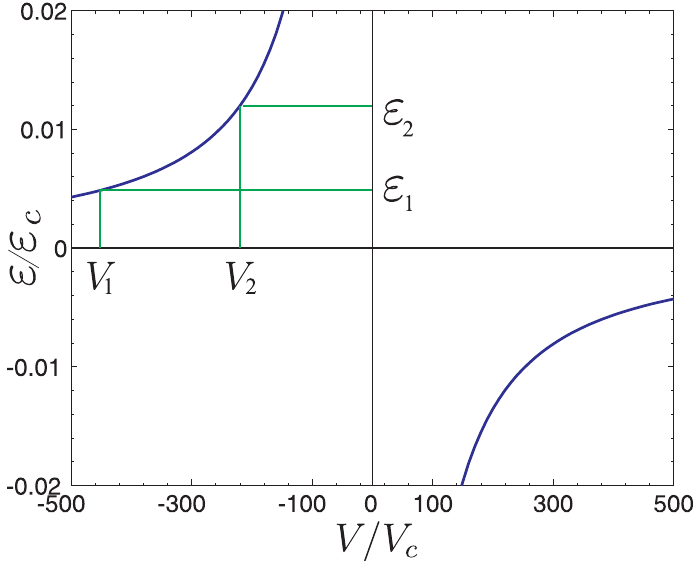
Figure 3. Dependence of resonant energy levels ε of a state localized on a non-magnetic impurity with the potential V 0 Equation (16), where ε c = ¯ h 2 / ( m e a 2 a 0 is the distance between carbon atoms. Localized states without magnetic correlations.